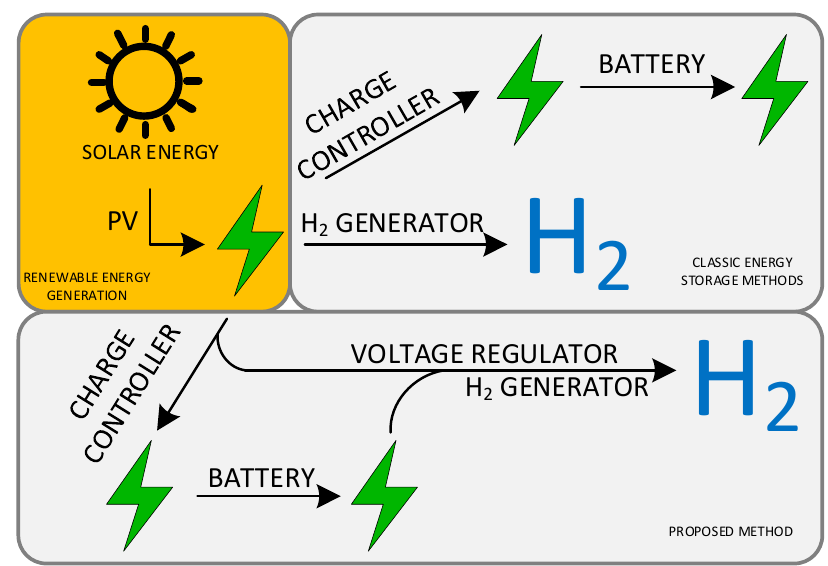
Figure 14. The overall idea of the proposed energy storage system.